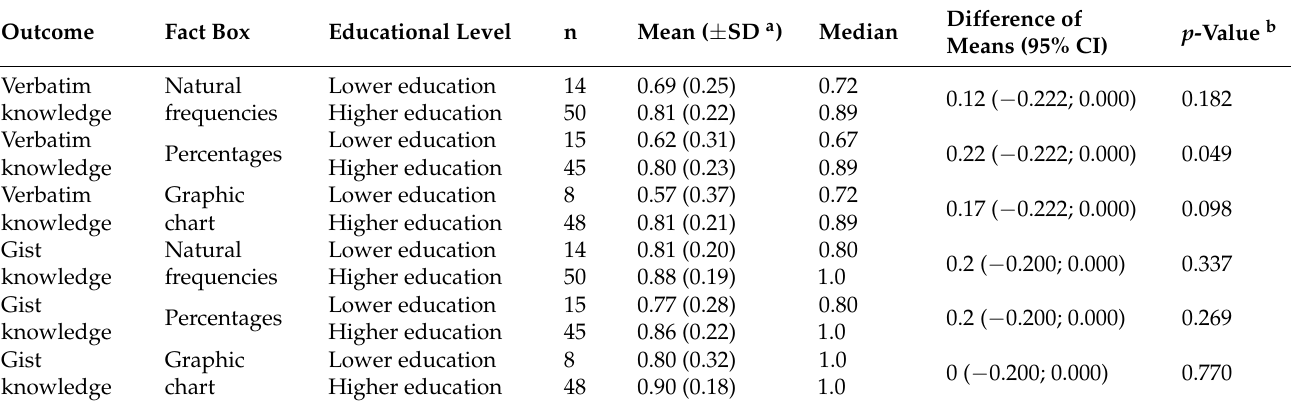
Table 4. Knowledge by educational